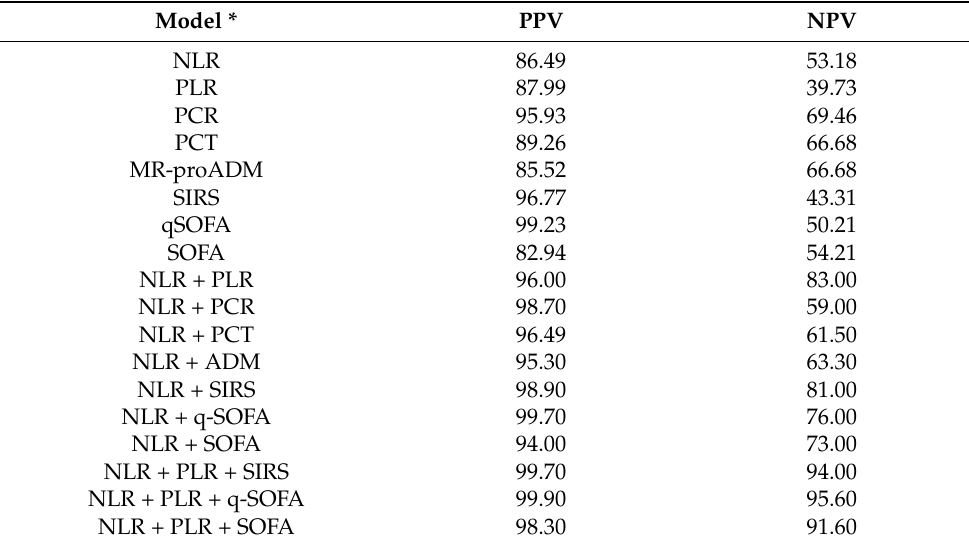
Table 3. Comparison of the diagnostic role of NLR with other inflammatory markers or clinical scores: positive predictive value (PPV) and negative predictive value